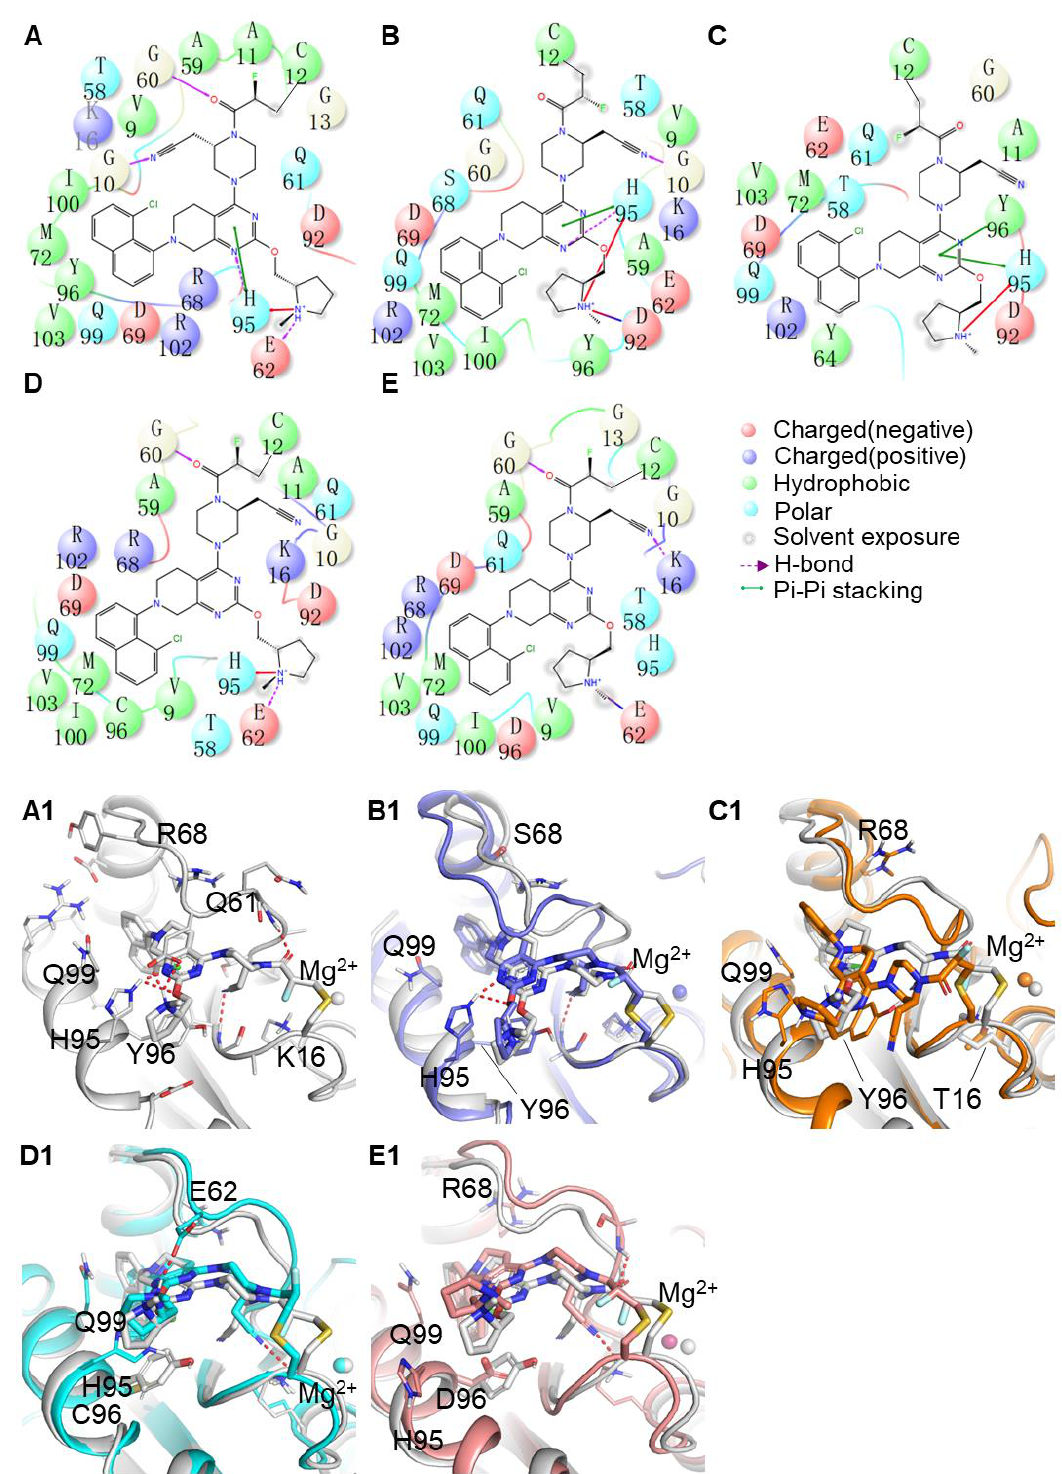
Figure 6. ( A – E ) Binding interactions in 2D representation of the studied MRTX849 bound to KRAS G12C, G12C-R68S, G12C-K16T, G12C-Y96C and G12C-Y96D, respectively. ( A1 – E1 ) The 3D presen- tations of the binding modes in the switch- Ⅱ pocket of KRAS G12C, R68S, G12C-K16T, G12C-Y96C and G12C-Y96D with AMG510 shown in gray, orange, blue, cyan, and pink, respectively. The Mg 2+ is shown as a sphere.